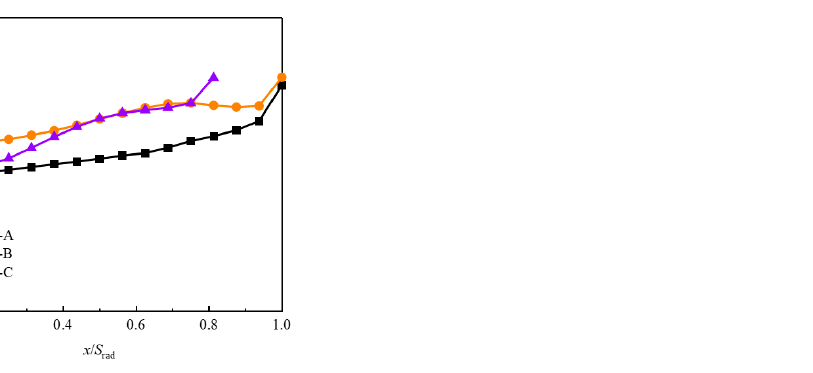
Figure 22. Time-averaged sealing efficiency variations along the axial direction at the middle section of the sealing cavity for IF = 0.6%.